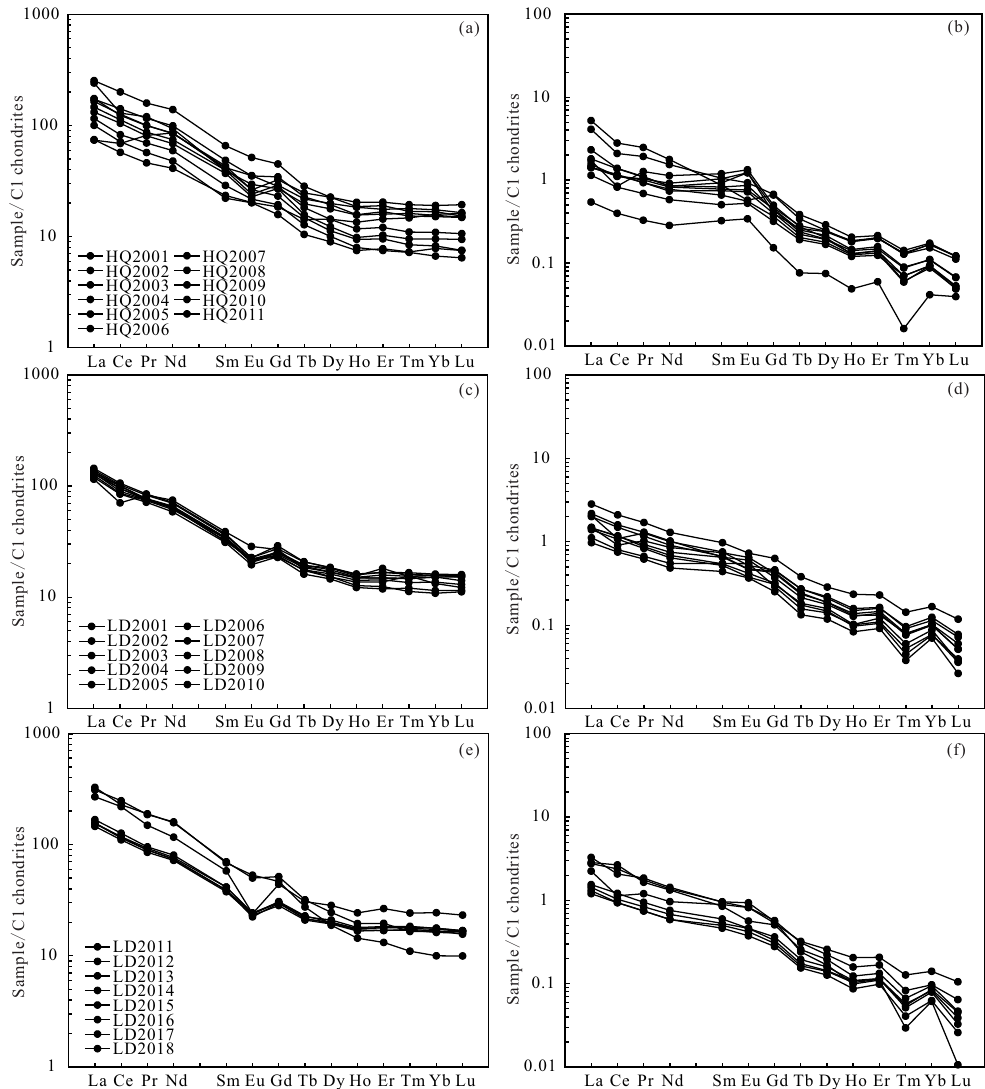
Figure 3. Chondrite-normalized REE patterns of rhizosphere soils and roots of Scutellaria baicalensis . ( a ) Rhizosphere soils in NGHs; ( b ) Roots in NGHs; ( c ) Rhizosphere soils in APHs; ( d ) Roots in APHs; ( e ) Rhizosphere soils in BCHs; ( f ) Roots in